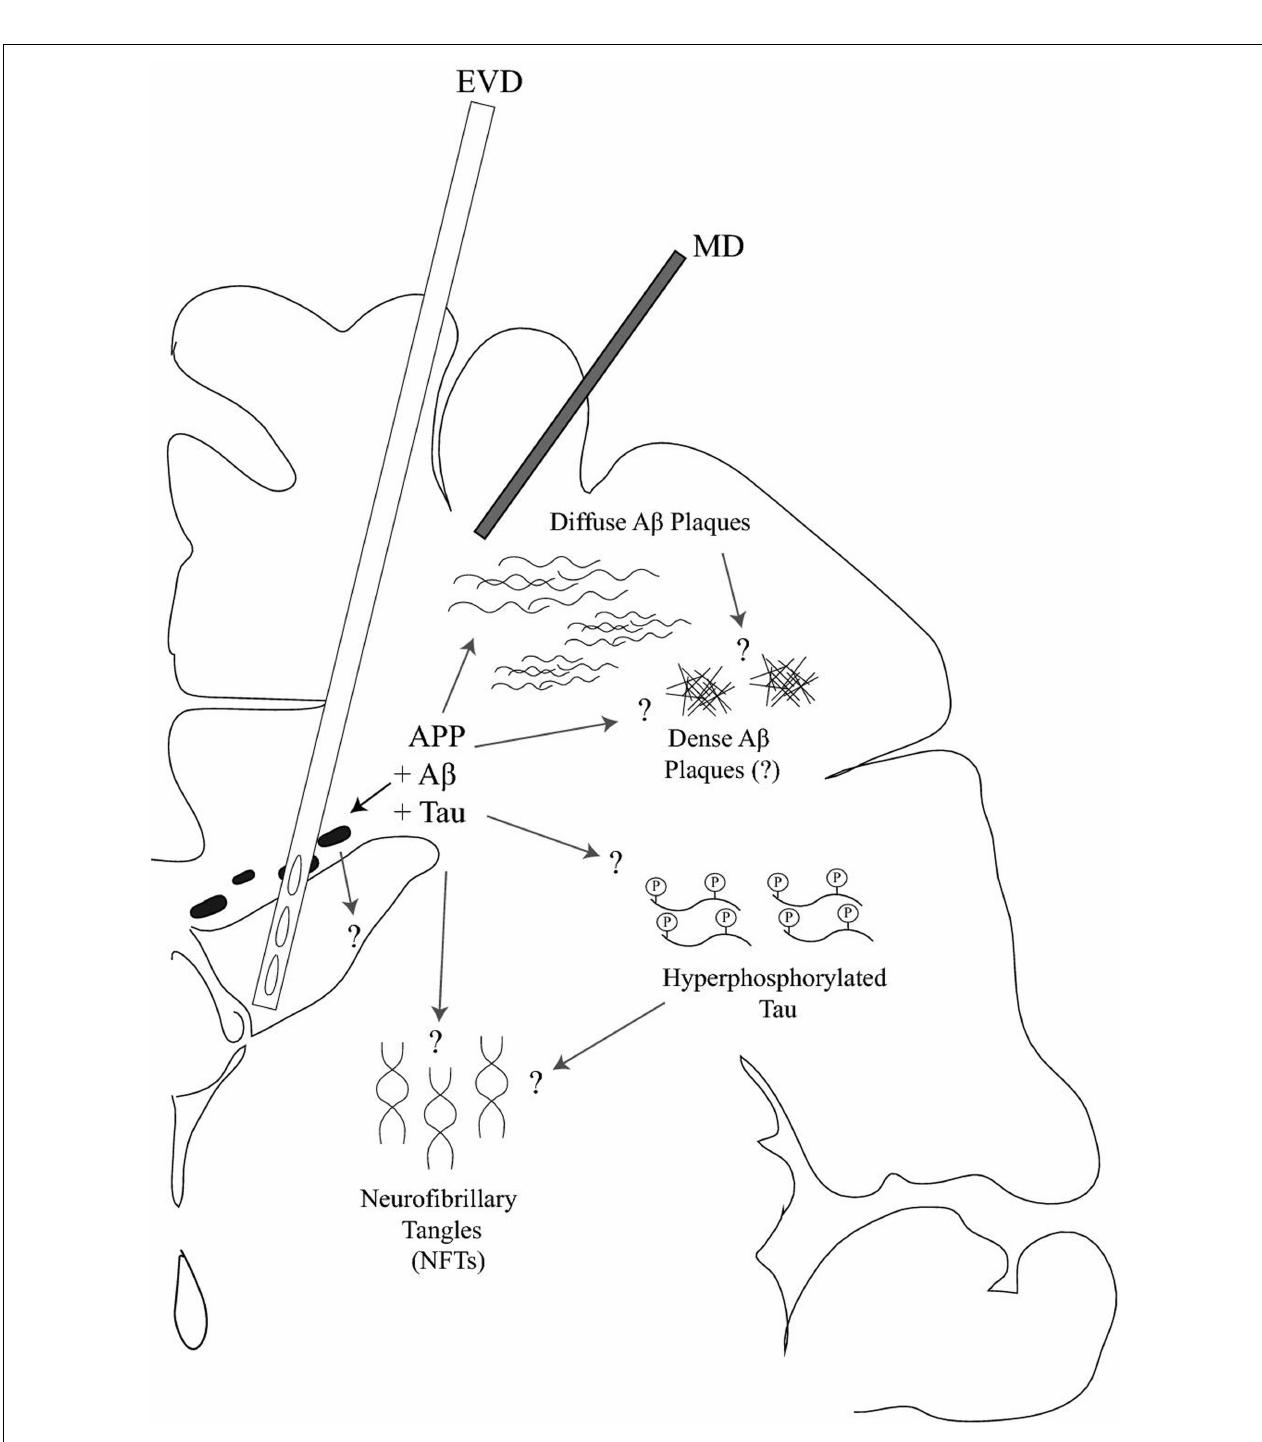
many years post-injury. Alternatively, A β peptides may also be produced by normal neuronal activity and be reduced byTBI. Neurofibrillary tangles (NFTs) can also be formed afterTBI as a consequence of hyperphosphorylated tau. In humans, NFT formation does not appear to occur acutely and has mainly been observed beyond 4weeks post-injury following a single, severeTBI. However, hyperphosphorylated tau aggregations can be observed as a characteristic observation following repetitive mildTBI.The question marks illustrate the unknown features of A β and tau accumulation, their release into the CSF or ISF, or the dynamic distribution between the CSF and ISF levels of A β and